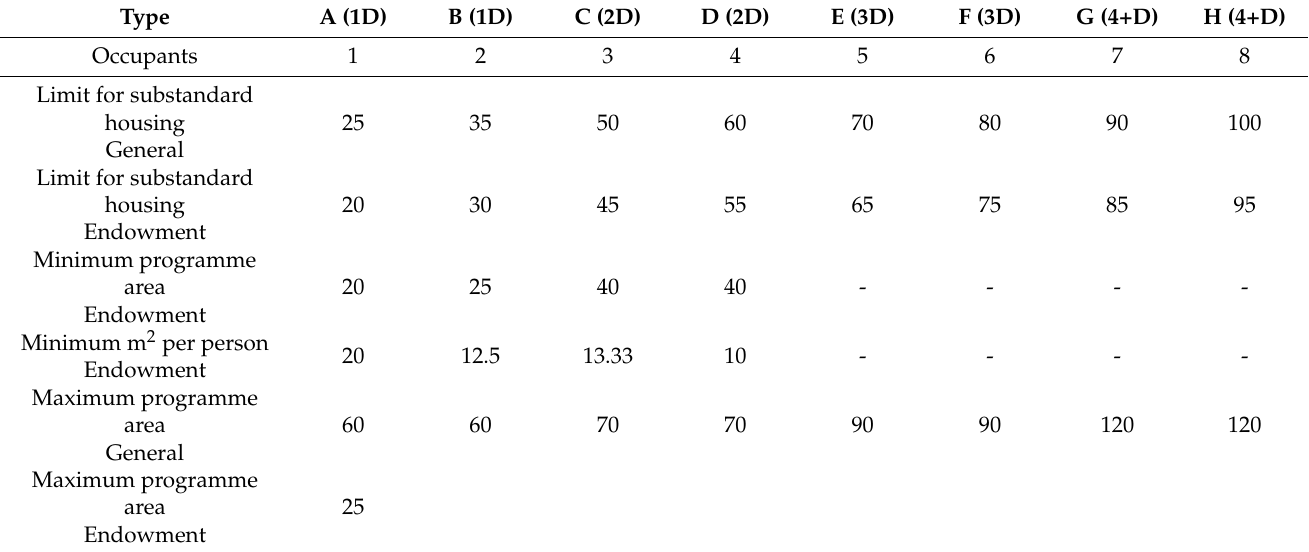
Table 7. Comparative between minimum surface definition in article 5 and the minimum basic